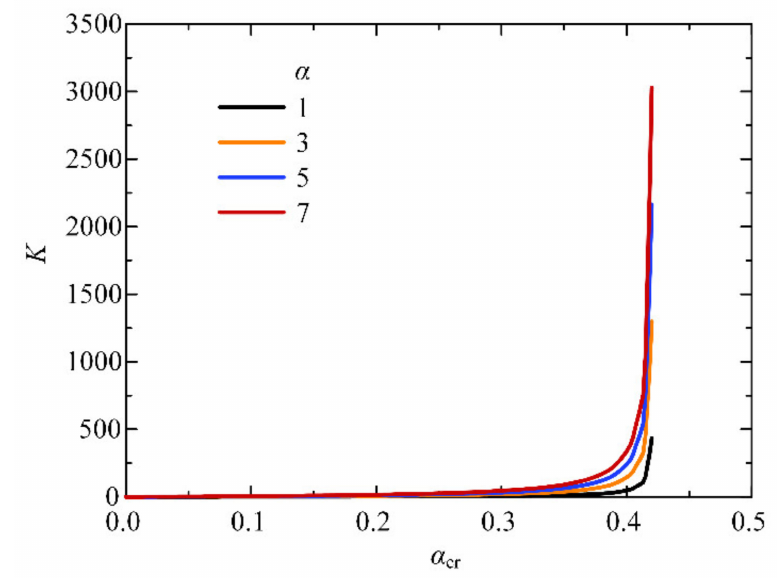
Figure 14. Relationship between parameter K and negative moment region factor α cr .